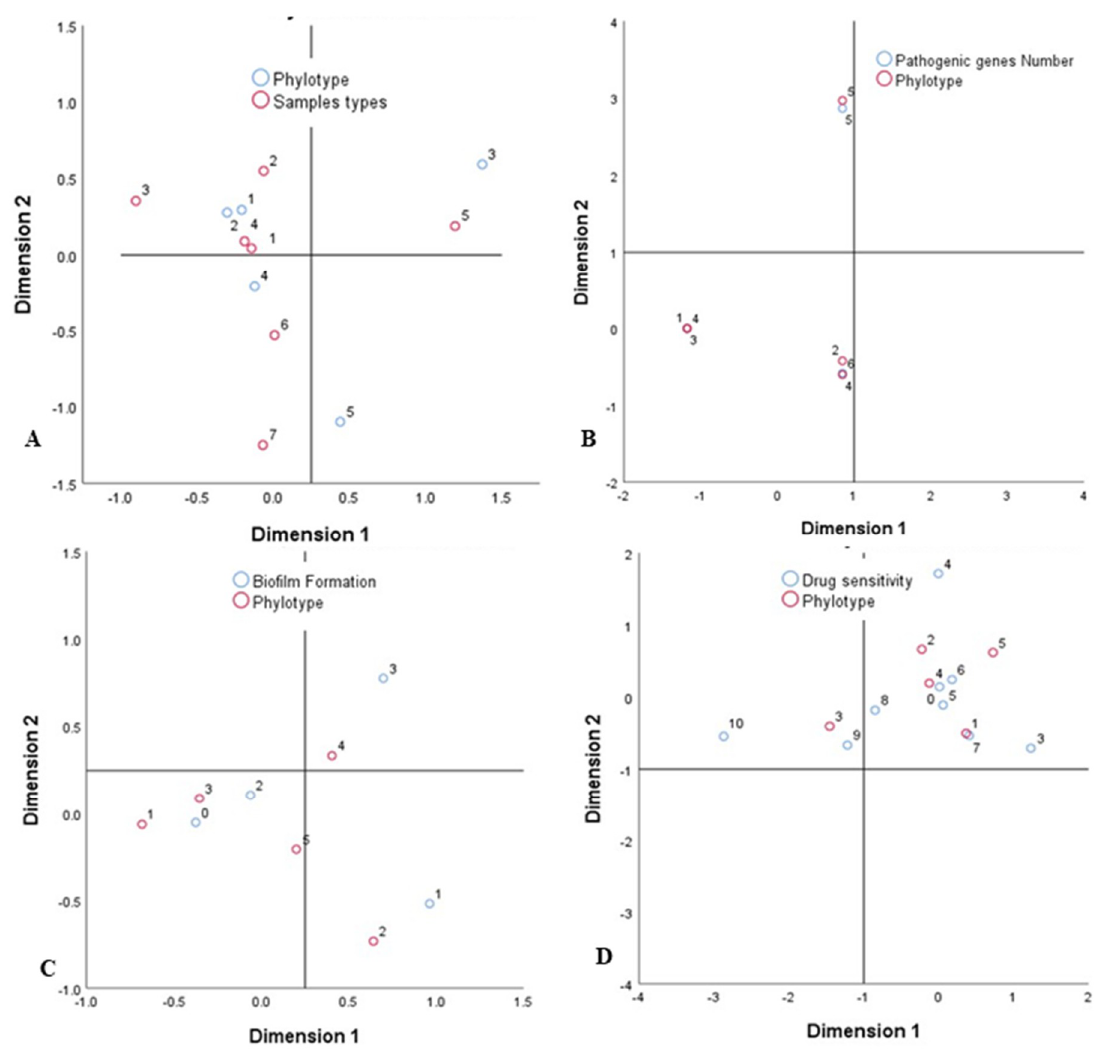
Figure 9. Correspondence analyses (CA) for the categorical variables. Sample types, pathogenicity, and phylogroups that are similar where this two-dimensional representation explain 100% of the total variation, with 68.55% explained by the first dimension, and 31.45% by the second dimension. On the other hand, for the drug sensitivity and biofilm formation, the representation explains discriminatory variations by the respective dimension. Here ( A ) represents phylotypes (white circle) vs sample types relation (red circle); ( B ) represents phylotypes (red circle) vs pathogenic gees relation (white circle); ( C ) represents phylotypes (red circle) vs biofilm formation (white circle); ( D ) represents phylotypes (red circle) vs drug sensitivity (white circle).